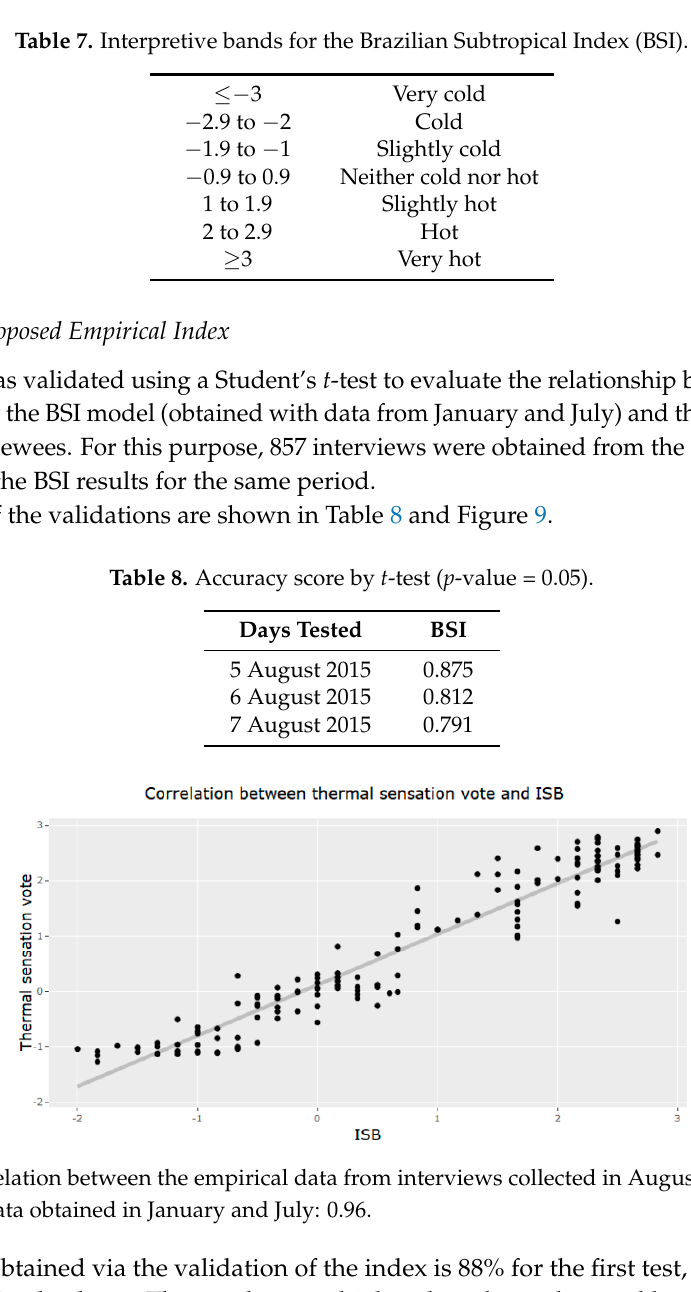
Figure 9. Correlation between the empirical data from interviews collected in August and the model made by the data obtained in January and July: 0.96.